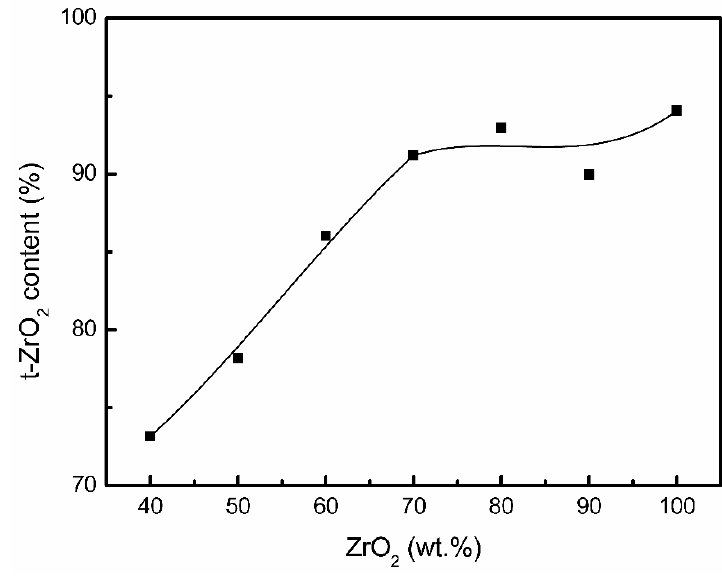
Figure 4. t-ZrO 2 phase content with different ZrO 2 weight ratios.